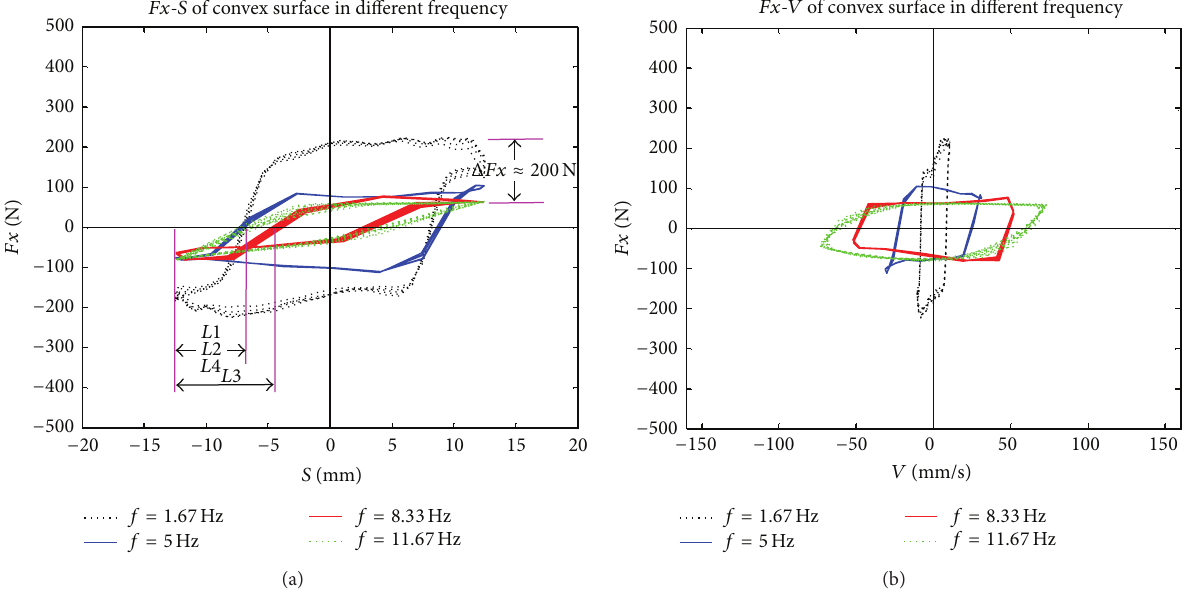
Figure12:Thepatternsof(a)relativedisplacementand(b)relativevelocityduringthestablefrictionprocessofconvexsurfaceatfourdifferent reciprocating frequencies.